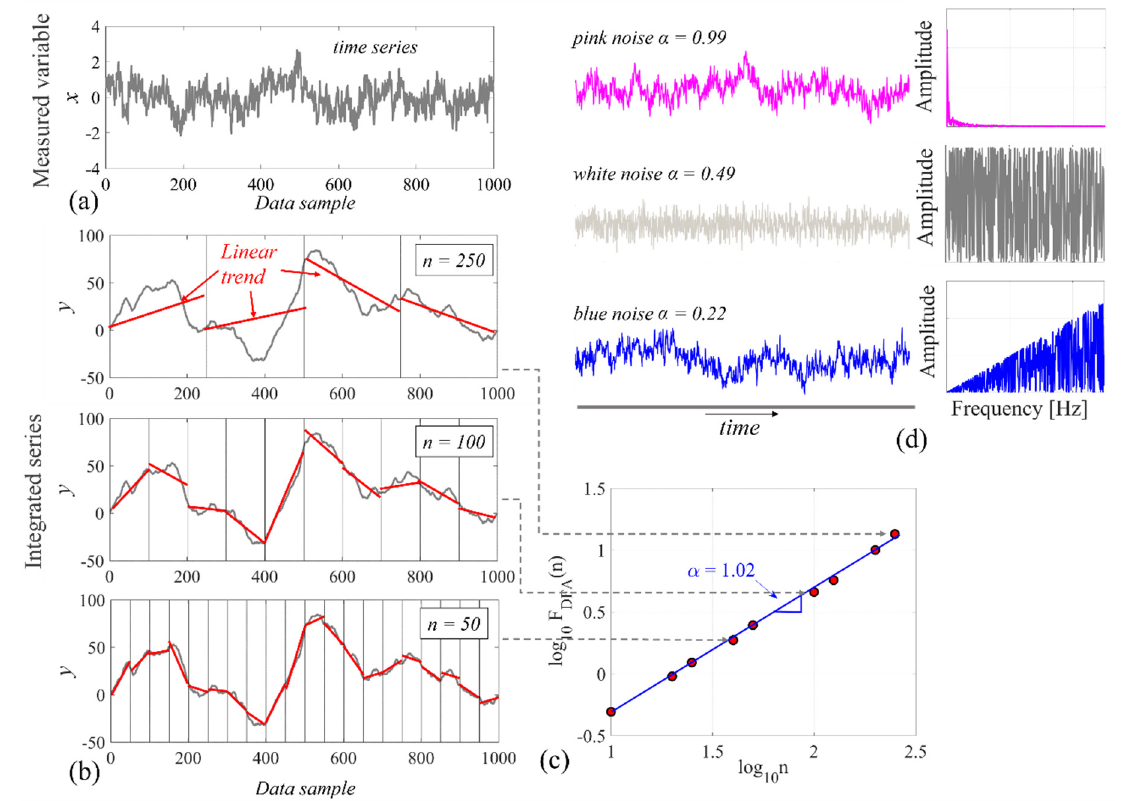
Figure 2. Graphical illustration of the DFA steps. ( a ) Example of time series; ( b ) integrated series divided into different size windows with their corresponding linear-fit trends; ( c ) log-log plot of average fluctuations F DFA ( n ) versus window sizes n . The estimated scaling exponent α is the slope of the least-squares fitted line; ( d ) representative examples of white (random), pink (fractal, long-range correlated, slightly persistent), and blue (anti-persistent) time and power-spectrum series. (Adapted from ref. [37]).